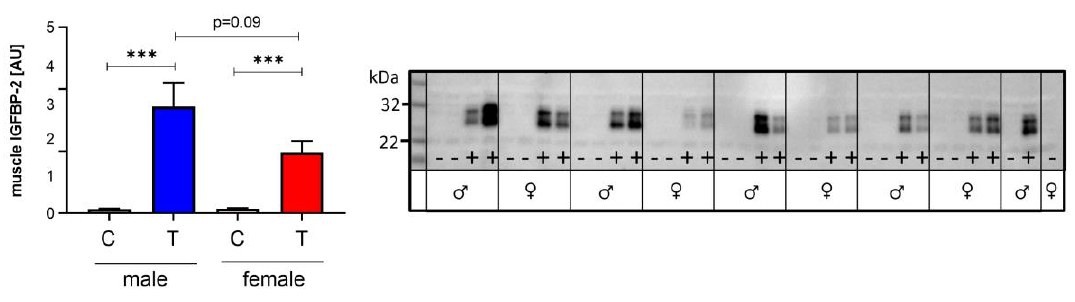
Figure 3. Expression of IGFBP-2 in muscle extracts from male (blue) and female (red) IGFBP-2 (T) and non-transgenic (C) littermates (DU6P/C57BL/6). Western immunoblotting was performed under reducing conditions. Immunoreactivity was present at two different molecular weights, which may represent IGFBP-2 with and without the C-terminal secretory signal peptide (mean ± SEM; age: 7 weeks; n = 9 for each group; +: IGFBP-2 transgenic; -: non-transgenic control; ***: p < 0.001).